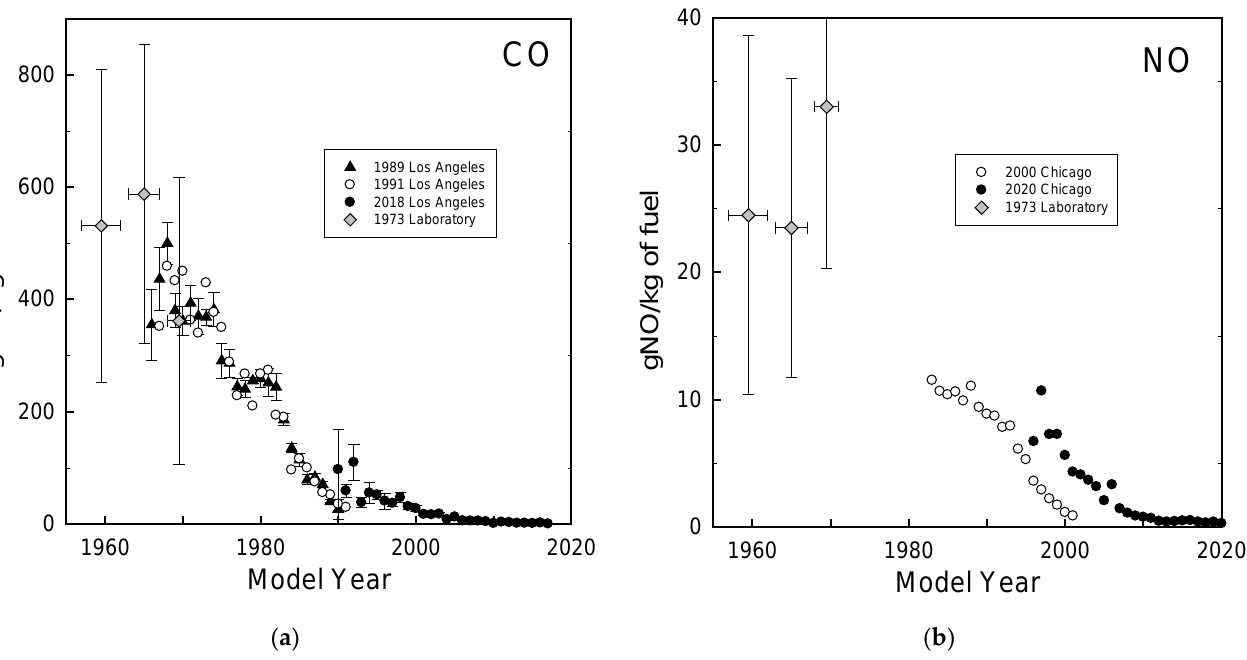
Figure 2. Emissions of CO ( a ) and NO ( b ) as a function of vehicle model year measured during on-road measurements conducted by Stedman, Bishop, and the research group at the University of Denver in Los Angeles and Chicago in 1989, 1991, 2000, 2018, and 2020 and in laboratory measure- ments by Fegraus et al. in 1973.